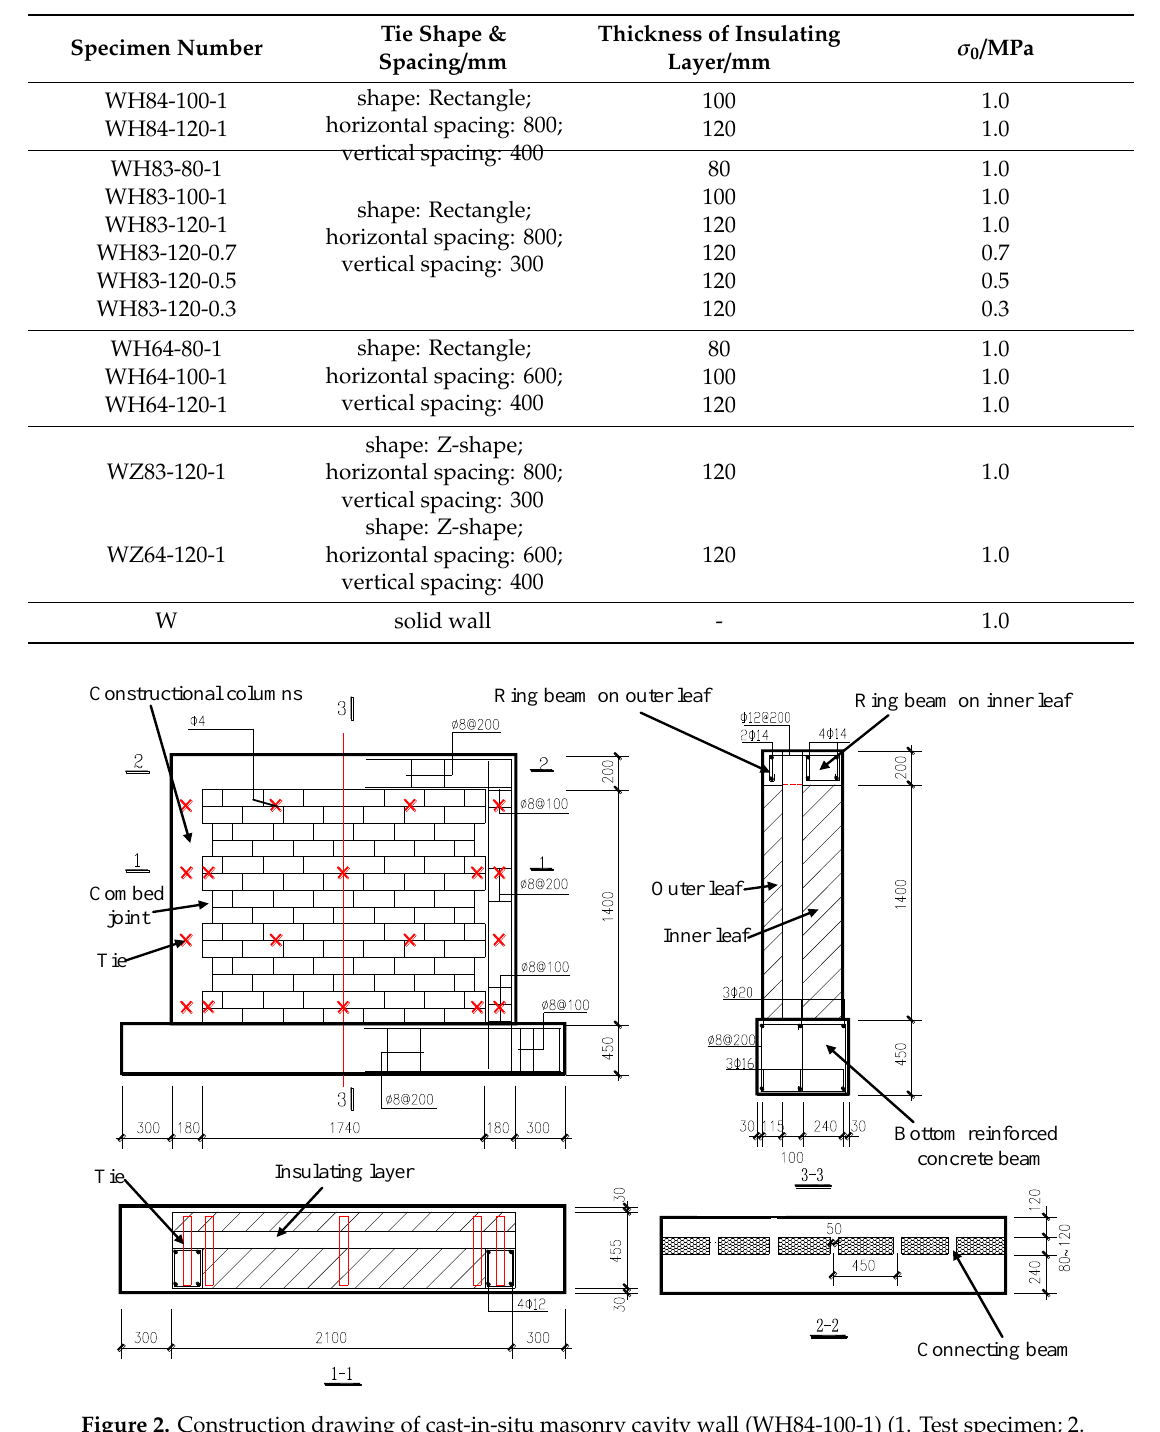
Figure 2. Construction drawing of cast-in-situ masonry cavity wall (WH84-100-1) (1. Test specimen; 2. Load sensor; 3. Vertical actuator; 4. Fixing beam; 5. Steel roller; 6. Reaction frame for vertical loading; 7. Ground anchor; 8. Load-distributing beam; 9. Reaction wall;10. Horizontal actuator; 11. Displacement sensor; 12. Bottom RC beam).